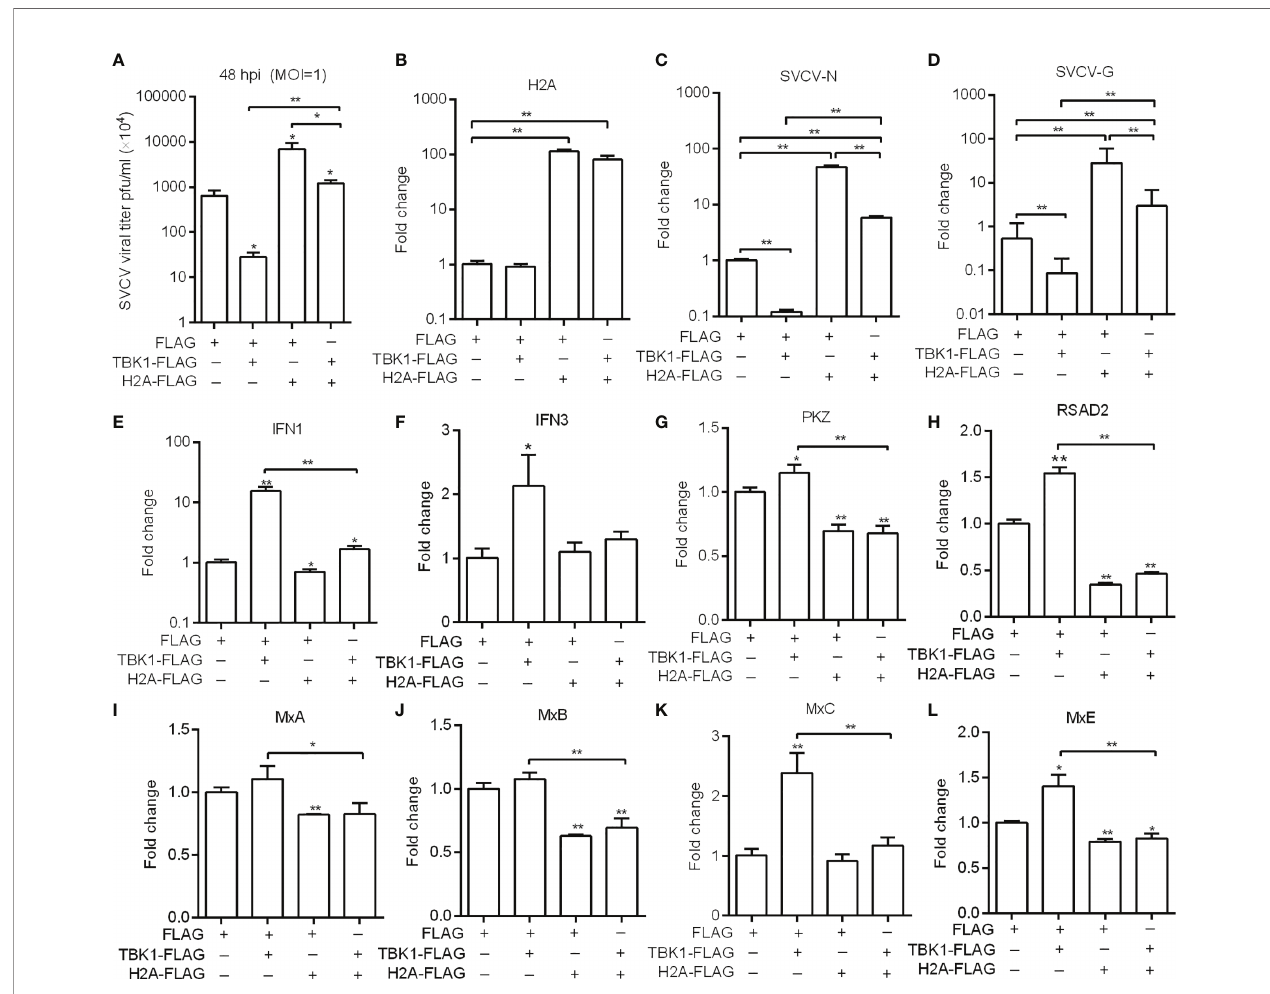
FIGURE 5 | Zebra fi sh histone H2A inhibits the effects mediated by TBK1. (A) Effect of zebra fi sh histone H2A on the TBK1-mediated antiviral activity. (B) The con fi rmation of zebra fi sh histone H2A expression in the histone H2A-overexpressed ZF4 cells with SVCV infection. (C) Effect of zebra fi sh histone H2A on the expression of SVCV-N gene mediated by TBK1. (D) Effect of zebra fi sh histone H2A on the expression of SVCV-G gene mediated by TBK1. (E) Effect of zebra fi sh histone H2A on the expression of IFN1 mediated by TBK1. (F) Effect of zebra fi sh histone H2A on the expression of IFN3 mediated by TBK1. (G) Effect of zebra fi sh histone H2A on the expression of PKZ mediated by TBK1. (H) Effect of zebra fi sh histone H2A on the expression of RSAD2 mediated by TBK1. (I) Effect of zebra fi sh histone H2A on the expression of MxA mediated by TBK1. (J) Effect of zebra fi sh histone H2A on the expression of MxB mediated by TBK1. (K) Effect of zebra fi sh histone H2A on the expression of MxC mediated by TBK1. (L) Effect of zebra fi sh histone H2A on the expression of MxE mediated by TBK1. For (A – L) ZF4 cells were transfected with the indicated plasmids. At 36 h post-transfection, these cells were used for SVCV infection at an MOI of 1. At 48 hpi, the supernatants of transfected cells were collected for the determination of virus titers. The cell pellets of transfected cells were collected and used for qRT-PCR. Data represented means ± SEM (n = 3), and were tested for statistical signi fi cance. * p < 0.05; ** p < 0.01. The asterisk above the error bars indicates statistical signi fi cance using the group microinjected with empty plasmid as the control group. The asterisk above the bracket indicates statistical signi fi cance between the two groups connected by the